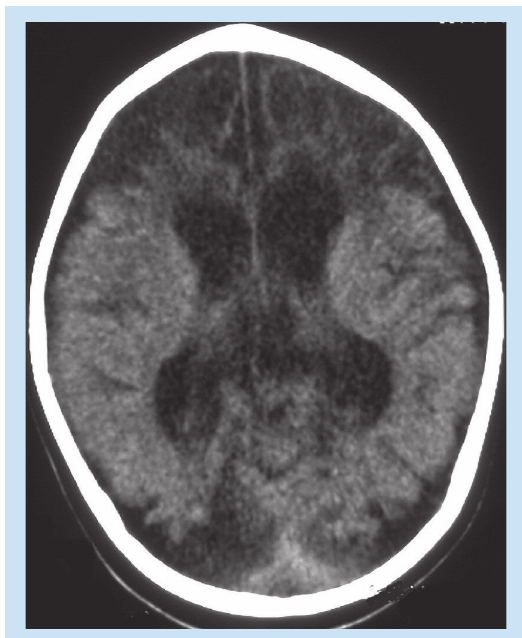
Fig. 2.3b. Delayed non-contrast CT demonstrated cystic changes bilaterally in the anterior watershed areas and pronounced localised atrophy in the poste- rior watershed areas. The ventricles are large either from ex vacuo dilatation or as a result of hydrocephalus caused by intraventricular